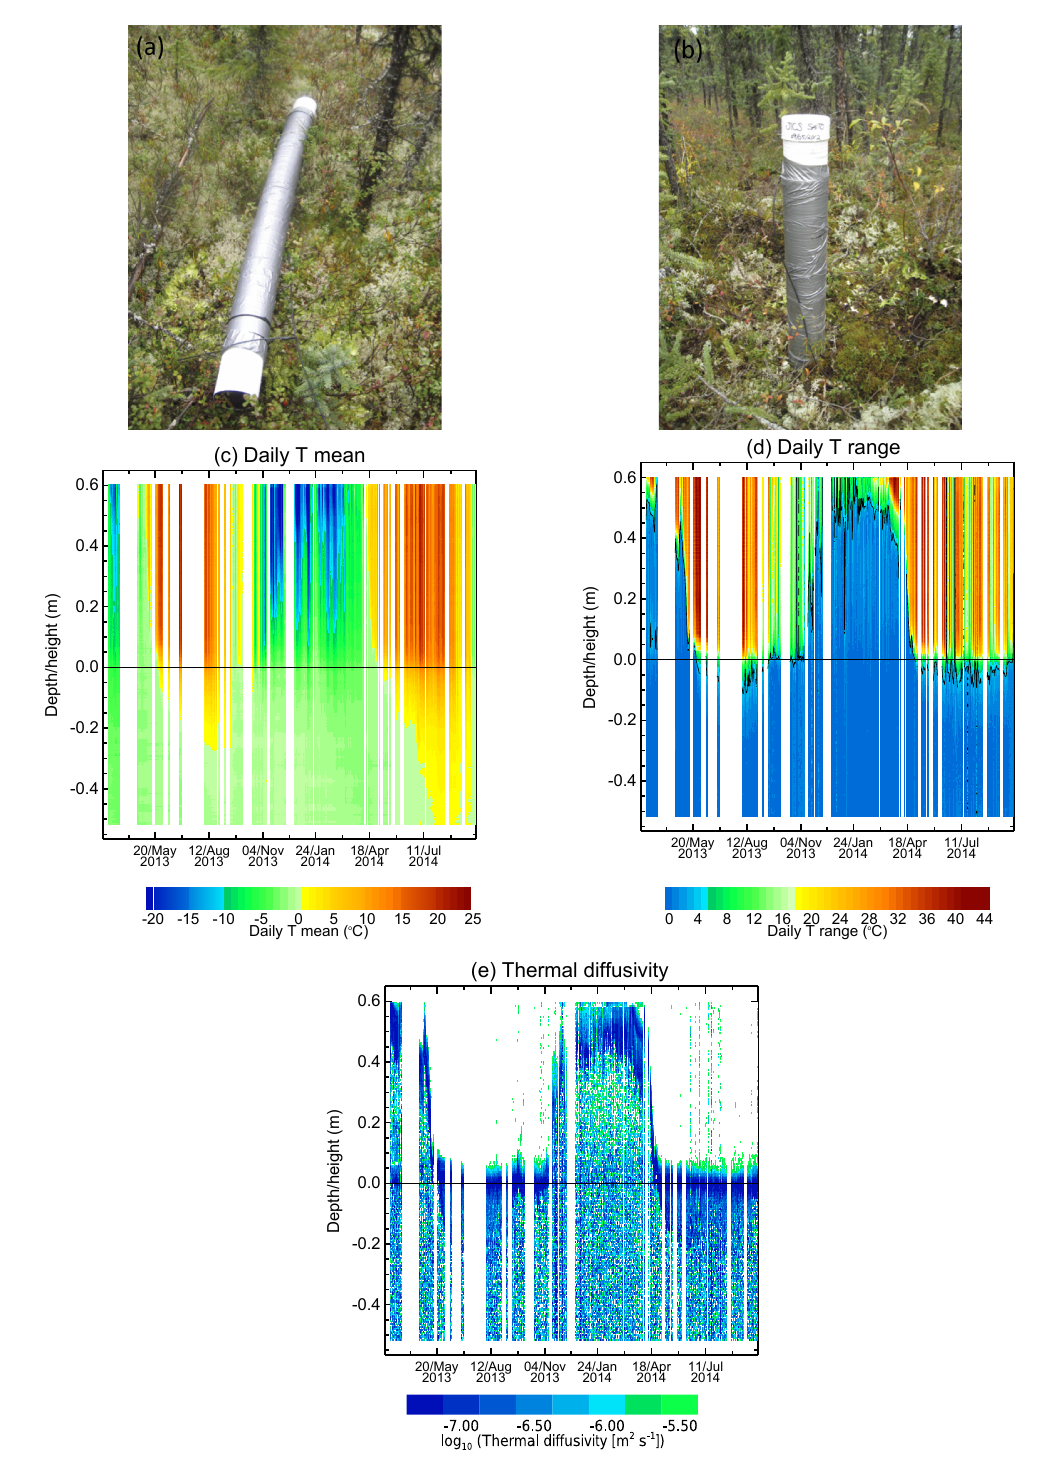
Figure 8. Subsurface and above-surface temperatures measured by vertical sections. (a) Photo of PVC tube with sensor cable wrapping prior to installation. (b) Photo of PVC tube with temperature sensor (vertical section) installed within a dense conifer forest. Depth-time profiles for (c) daily mean temperatures and (d) daily temperature range during 2013 snow melt period. (e) Same as (c) except for apparent thermal diffusivity (m 2 s − 1 ), shown in common logarithmic